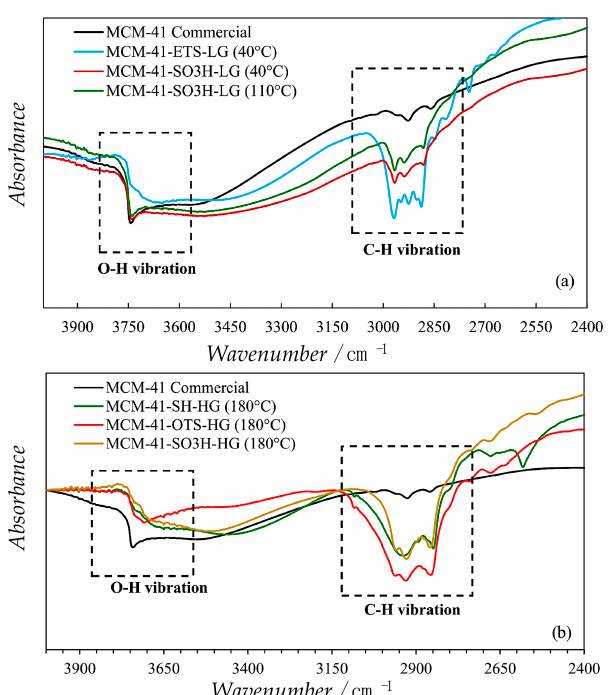
Figure 9. The disappearance of O-H vibration band coupled with the appearance of C-H vibration band after organosilane functionalization of MCM-41 in the case of ( a ) materials functionalized at low temperature of grafting (LG) and ( b ) materials functionalized at high temperature of grafting (HG). Adapted with permission from Langmuir 2019, 35, 6838–6852 , Reference [66]. Copyright (2019) American Chemical